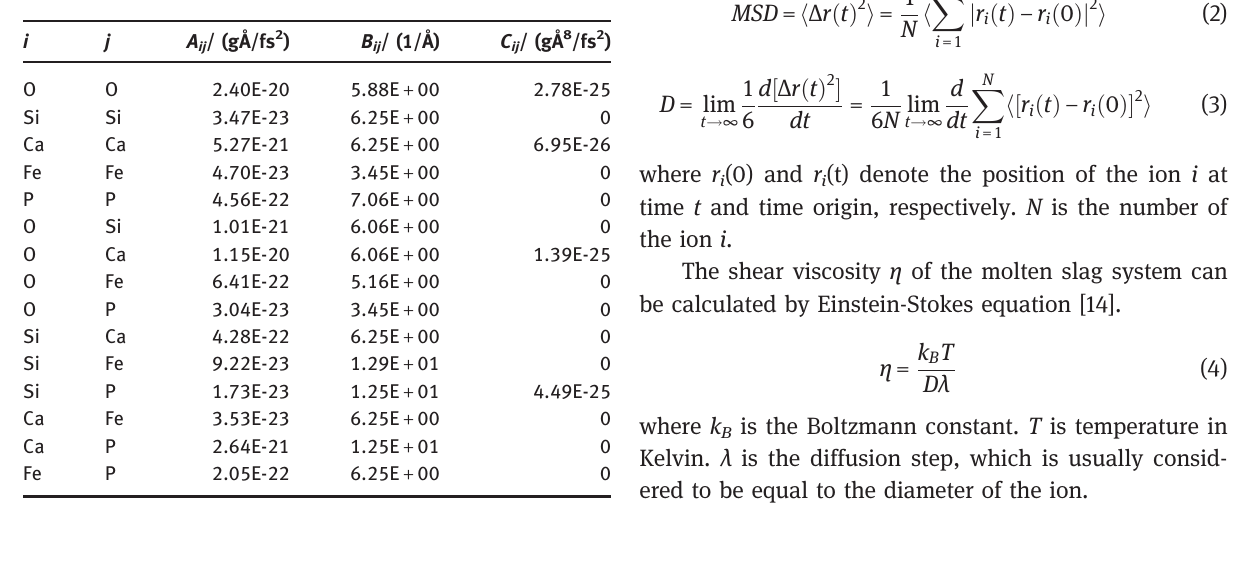
Table 2: Chemical compositions and number of atoms. Nos 1~4 slags concern the parameter series of slag basicity. No. 2 and Nos 5~8